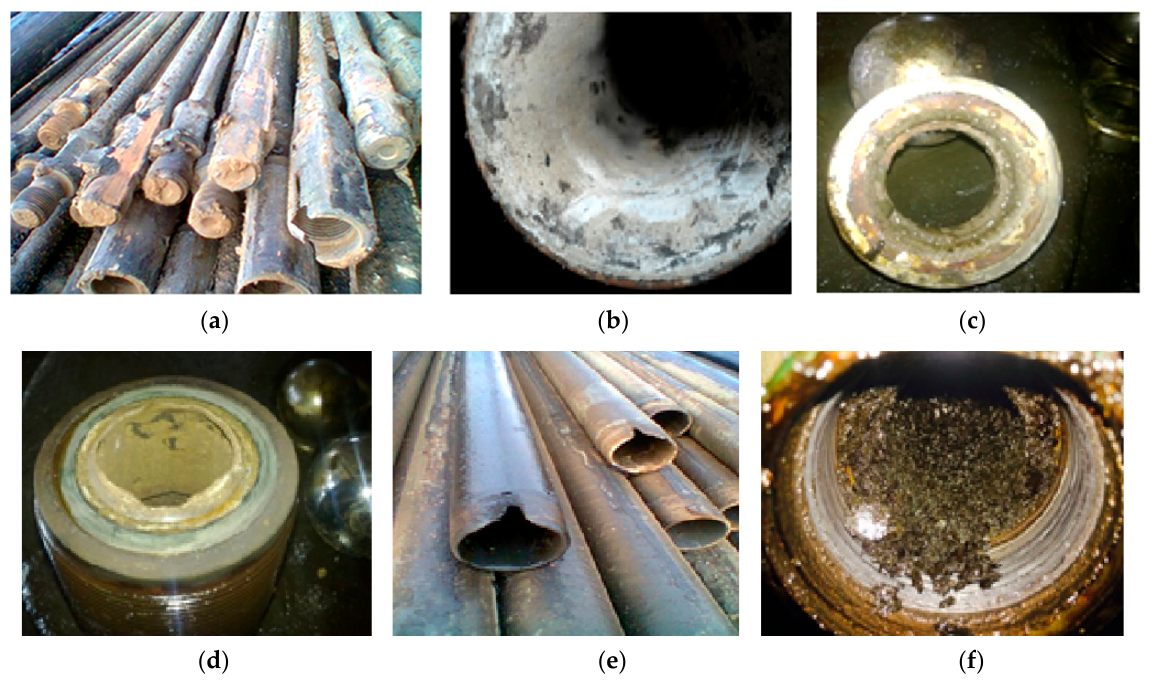
Figure 1. Types of wear of RDP elements [data provided by Munaymash plant, Kazakhstan]: ( а ) salt clogging; ( b ) hard deposits of gray color (salts); ( c ) salt deposits on the inner cavity of the cylinder; ( d ) the inner surface of the RDP element; ( e ) abrasion and breakage of threaded connections of pumping compressor pipes; ( f ) clogging of the RDP plunger with mechanical impurities. Table 1. Compositions of the studied oil.